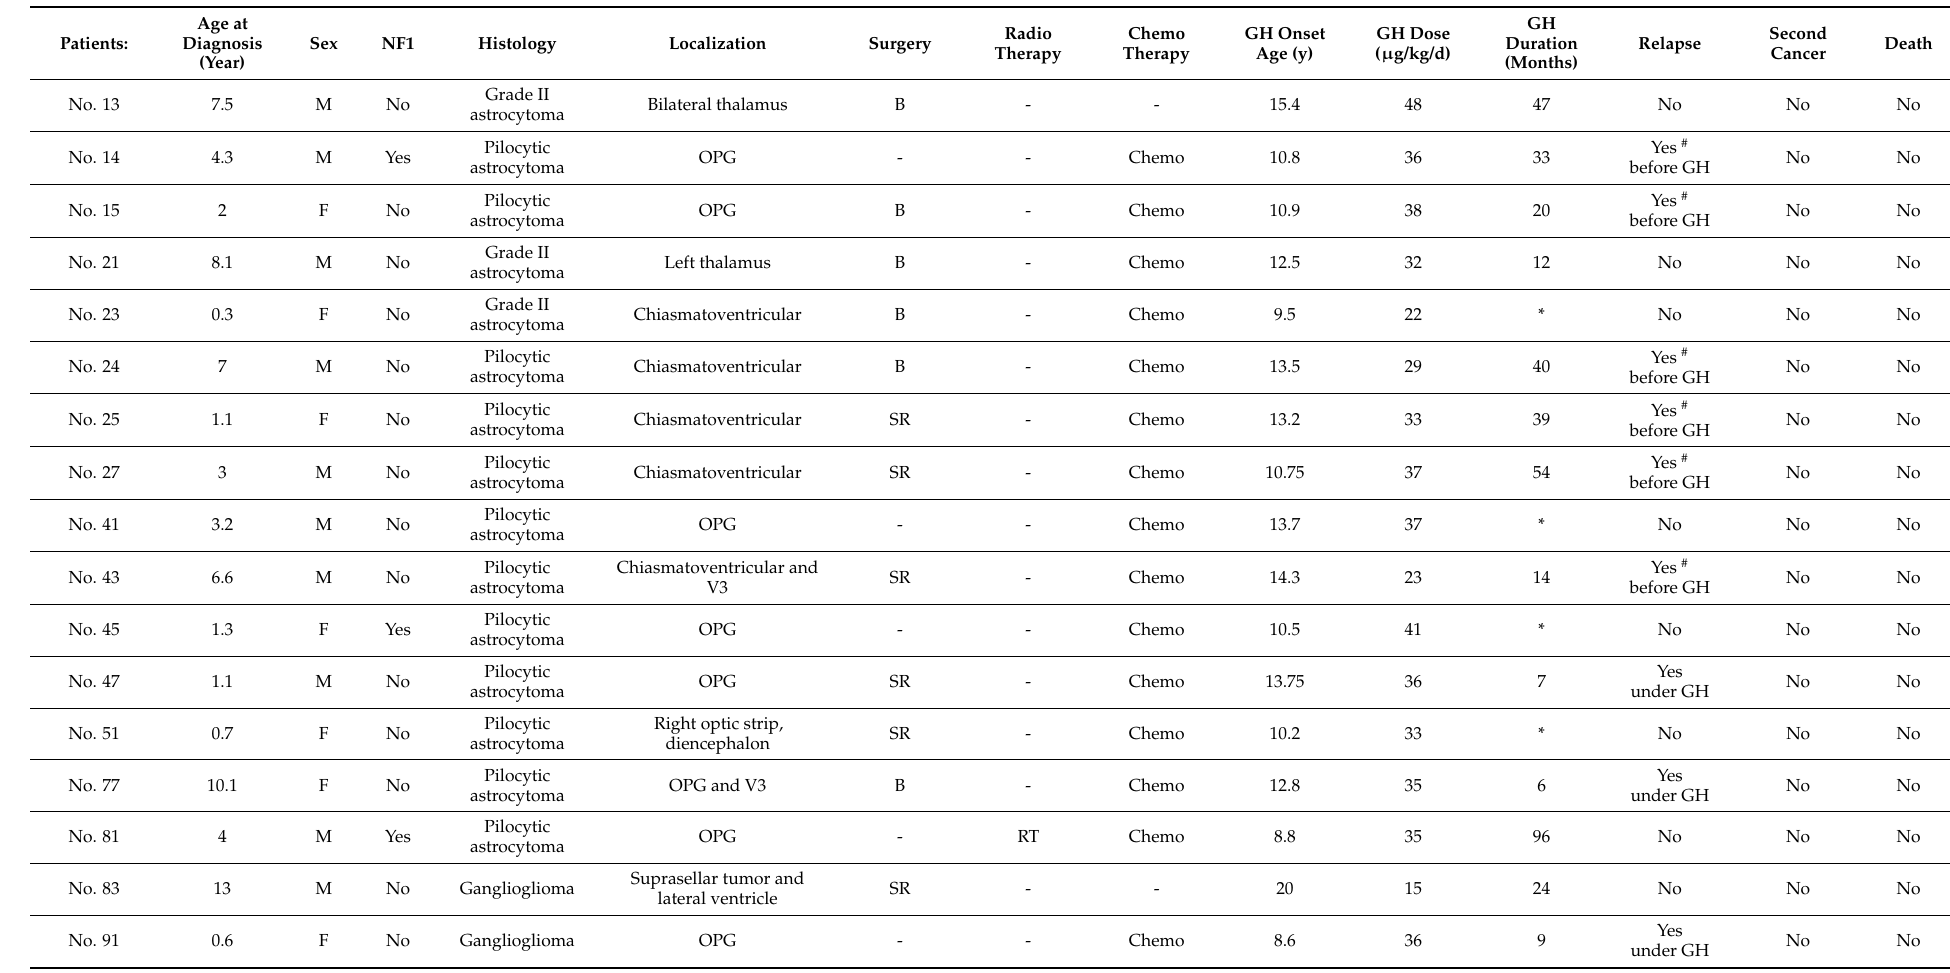
Table 2. Characteristics of patients treated with GH following a low-grade midline glial tumor between 1 January 1998 and 31 December 2016 at the Lille and Lyon